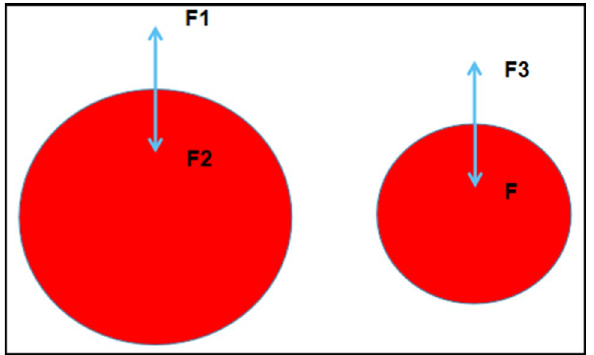
Figure 2. Schematic Diagram of Vascular Stress Analysis. We assume that a downward force F of magnitude F1 is exerted on the blood vessel wall and that this is offset by lateral pressure generated by blood on the blood vessel wall (F2), which deforms the blood vessel and results in it regaining its initial diameter. The diameter of the blood vessel is D at this moment. We can analyse the current state repeatedly and regard it as an ideal physical model provided that we ignore the local influence of other factors operating in the rats. At this time, the blood vessel is in a stress-free state without deformation. The forces acting on it are the downward force F, which we apply externally artificially, and the internal pressure of blood on the blood vessel wall with the diameter (d) at this moment. We term this F3 in the physical model. In this ideal model, the forces of F and F3 are also equal in theory. (Adobe Photoshop: 21.0.1 20,191,106.r.47 2019/11/06:3152b481f18 × 64 https ://www.adobe .com/cn/ produ cts/photo